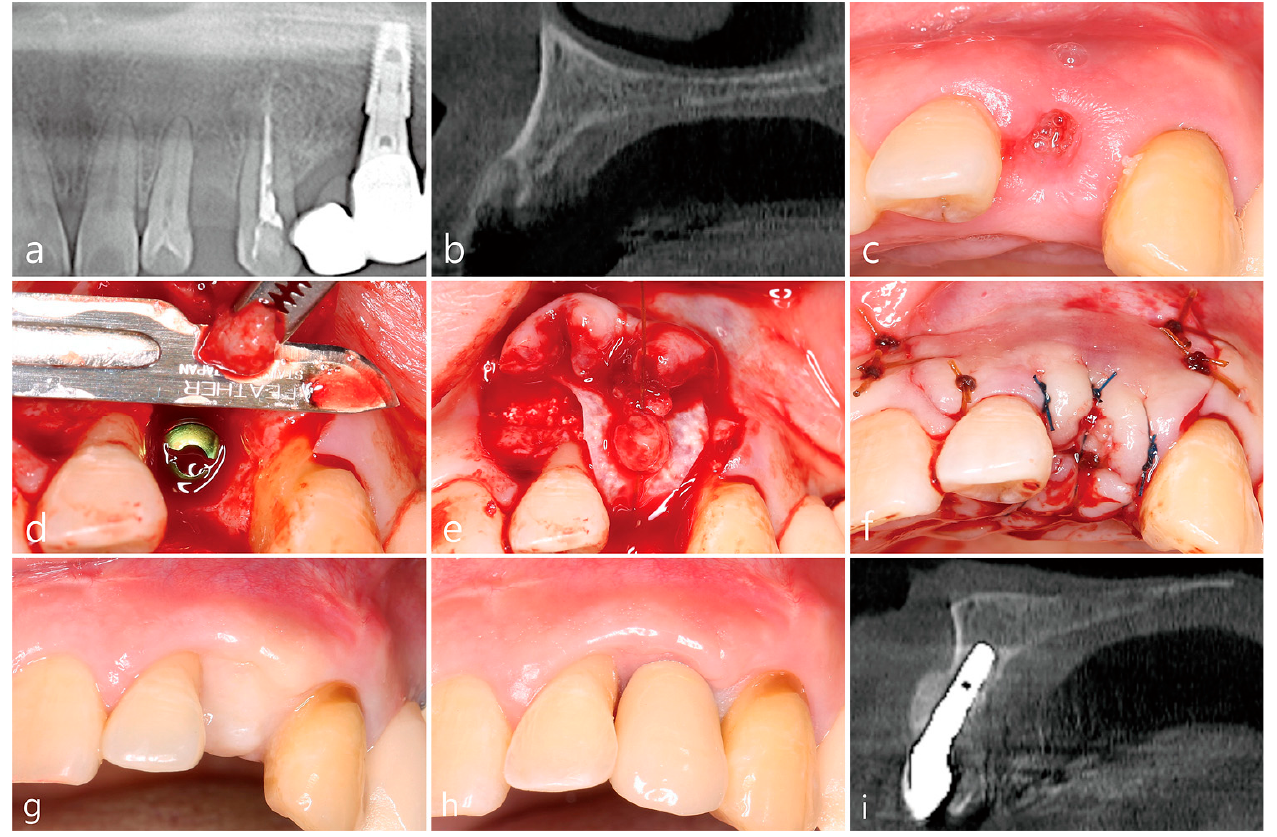
Figure 2. Clinical and radiological findings of case #2. ( a ) Pre-operative panoramic radiograph showing compromised extraction socket #23. ( b ) Cross-sectional image of CBCT #23 extraction socket showing loss of labial bone plate with ICT. ( c ) Pre-operative photograph showing extraction socket #23 (extracted prior to surgery). ( d ) Flap extension by dissection of the ICT attached to the buccal flap with the base attached to the existing flap after implant placement. ( e ) Bone graft and resorbable collagen membrane placement and extended IGT sutured to the palatal flap with resorbable sutures with 4-0 Catgut. ( f ) Flap closure with extended IGT. ( g ) Post-operative photograph showing healing with no flap exposure and sufficient amount of keratinized gingiva. ( h ) Final prosthesis #23. ( i ) Cross-sectional image of CBCT taken 29 months after prosthesis delivery with sufficient bone regenerated around the implant.